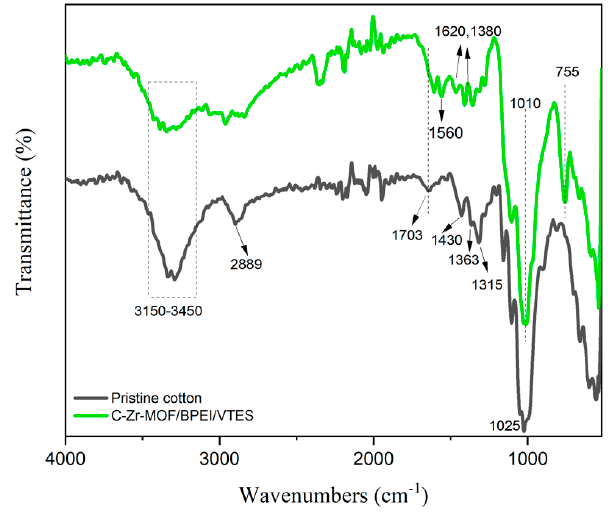
Figure 5. The FTIR spectra of the pristine cotton and C − Zr − MOF/BPEI/VTES sample.